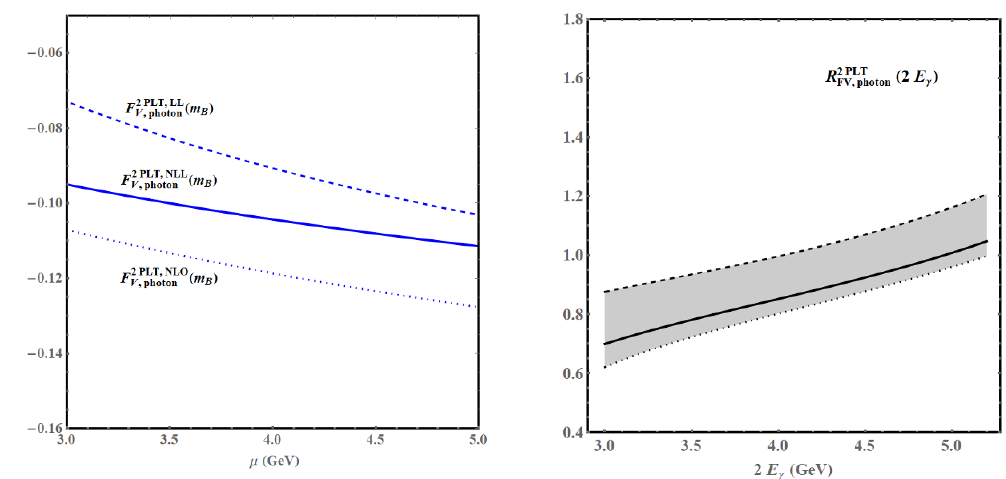
Figure 6 . Left : the renormalization scale dependence of the twist-two hadronic photon correction to the vector B ! (cid:13) form factor F V ( m B ) at LL (dashed), NLO (dotted), and NLL (solid) accuracy, respectively. Right : the photon-energy dependence of the ratio R 2PLT p ) =F 2PLT ; LL ( n (cid:1) p ) with the uncertainties from the variations of the renormalization scale (cid:22) V; photon